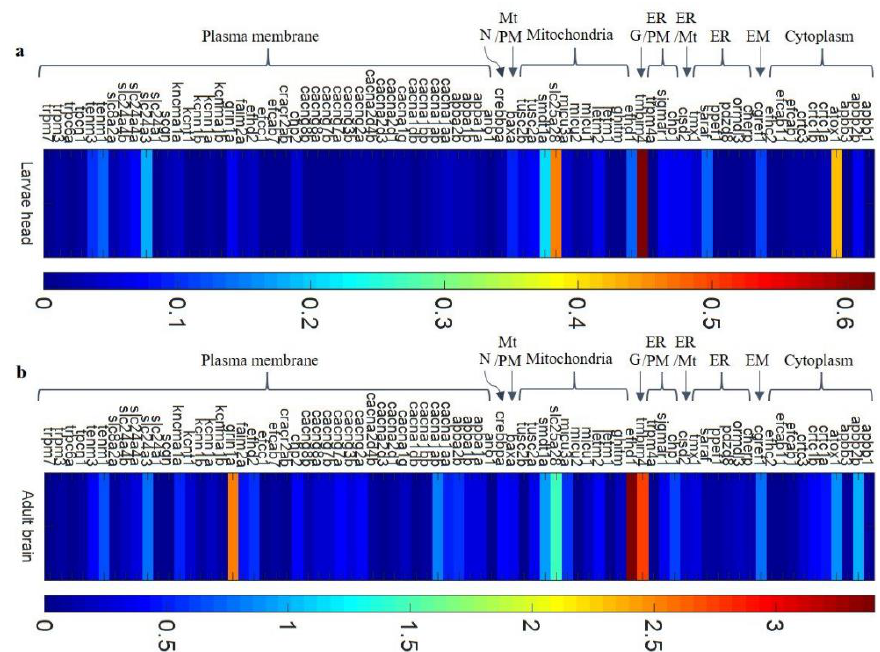
Figure 5. A heat map of the normalized expression levels of zebrafish brain CaTK genes, estimated by RT-PCR arrays: The expression levels of 77 CaTK genes in zebrafish brain tissue, including 14 genes for validation ( baxa , cacna1ab , cacng2a , chp1 , crebbpa , crtc3 , grin1a , kcnn1b , micu1 , slc24a4a , tenm3 , and trpm3 ; Table 7) , were normalized to the 4 reference genes. The expression levels were calculated using the ΔCq method with an assumption of equal efficiencies for all reactions. The relative mRNA levels are color-coded: dark blue (low) to red (high). Notice the different scales that are used for the results from larvae and adults. The RNA samples were obtained from larval heads ( a ) and from the brains of adult fish ( b ). n = 3. N, nucleus; EM, extracellular matrix; G, Golgi apparatus; Mt, mitochondria; PM, plasma membrane; and ER, endoplasmic reticulum.